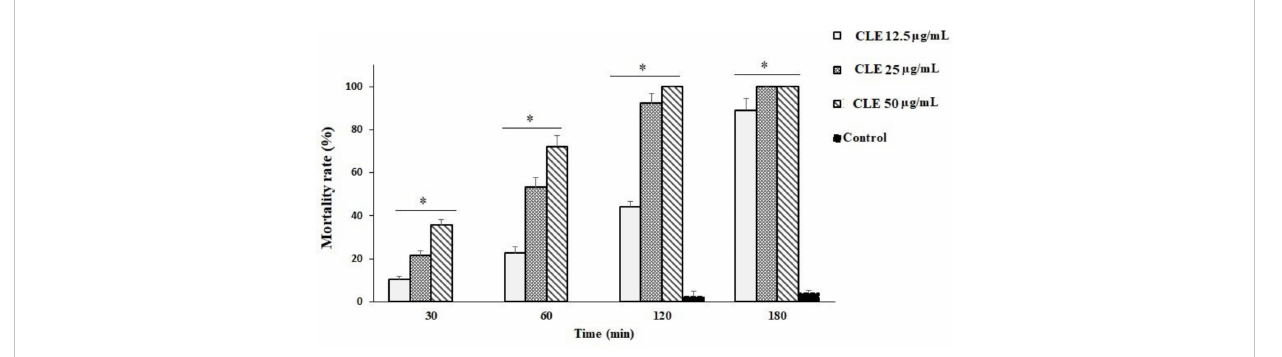
FIGURE 1 Effects of Curcuma longa essential oil (CLE) against Toxoplasma gondii tachyzoites after 0.5, 1, 2, and 3 h of incubation in comparison with the control group. Data are expressed as the mean ± SD (n = 3). *p < 0.001 compared with the control